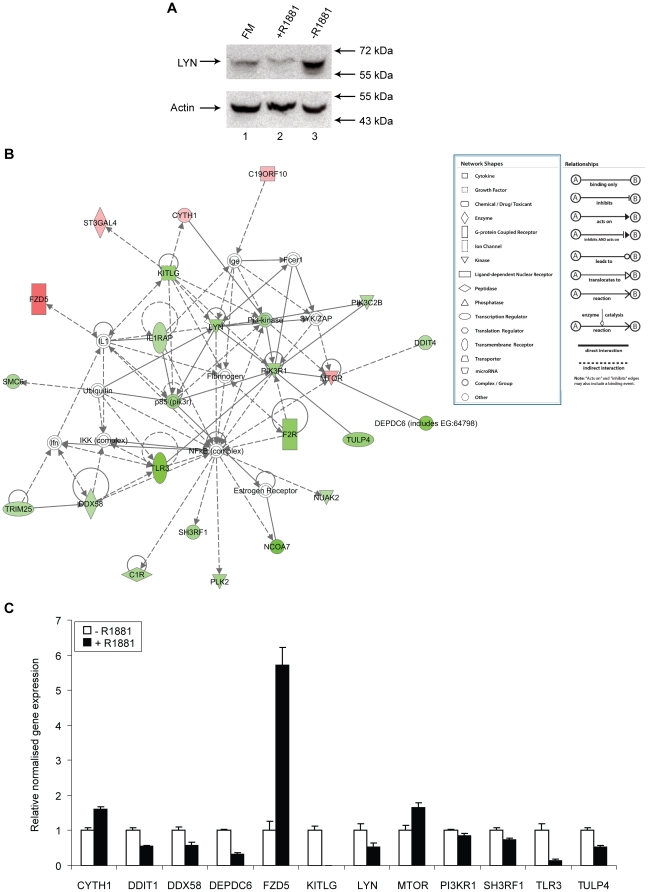
Expression of LYN and -associated genes are androgen-regulated in LNCaP cells.(A) Western analysis of LYN and actin (loading control) protein expression in cells grown in full medium, steroid-deplete medium, and following 24 hours of treatment with 10 nM R1881. (B) Ingenuity Pathway Analysis (IPA) of LYN-associated genes. Novel androgen-regulated genes identified in the present study are labelled in shades of red (up-regulated genes) or shades of green (down-regulated genes). (C) Expression of 12 novel androgen-regulated genes associated with LYN in steroid-deplete conditions (−, lanes 1–4) and after 24 hours of treatment with 10 nM R1881 (+, lanes 5–8) measured by multiplex RT-PCR. Levels of transcript expression were normalised to GAPDH levels, and data from experimental quadruplicates were used to obtain the mean ± SE for each transcript. A particularly high level of androgen-mediated gene activation was seen for the FZD5 gene, which encodes a transmembrane Wnt5a receptor. Other confirmed up-regulated genes included KITLG, which encodes the Kit ligand upstream of LYN in the pathway, and MTOR, which encodes a key regulator of cell growth. Similarly, we confirmed down-regulation of the novel androgen-regulated genes REDD1 (also known as DDIT4), which negatively regulates mTOR, and DEPDC6 which encodes an mTOR interacting protein.